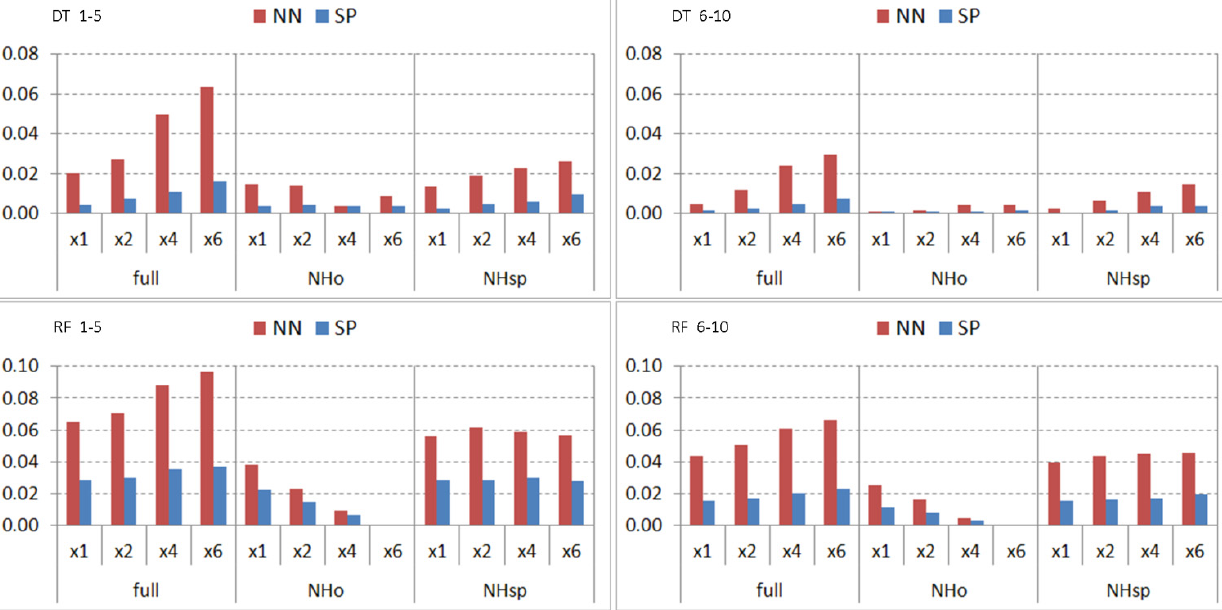
Figure 10. Influence of number of unlabeled samples added per self-training iteration using the class-based SNH in a circular (NH approach for the two enlarged training sets NN